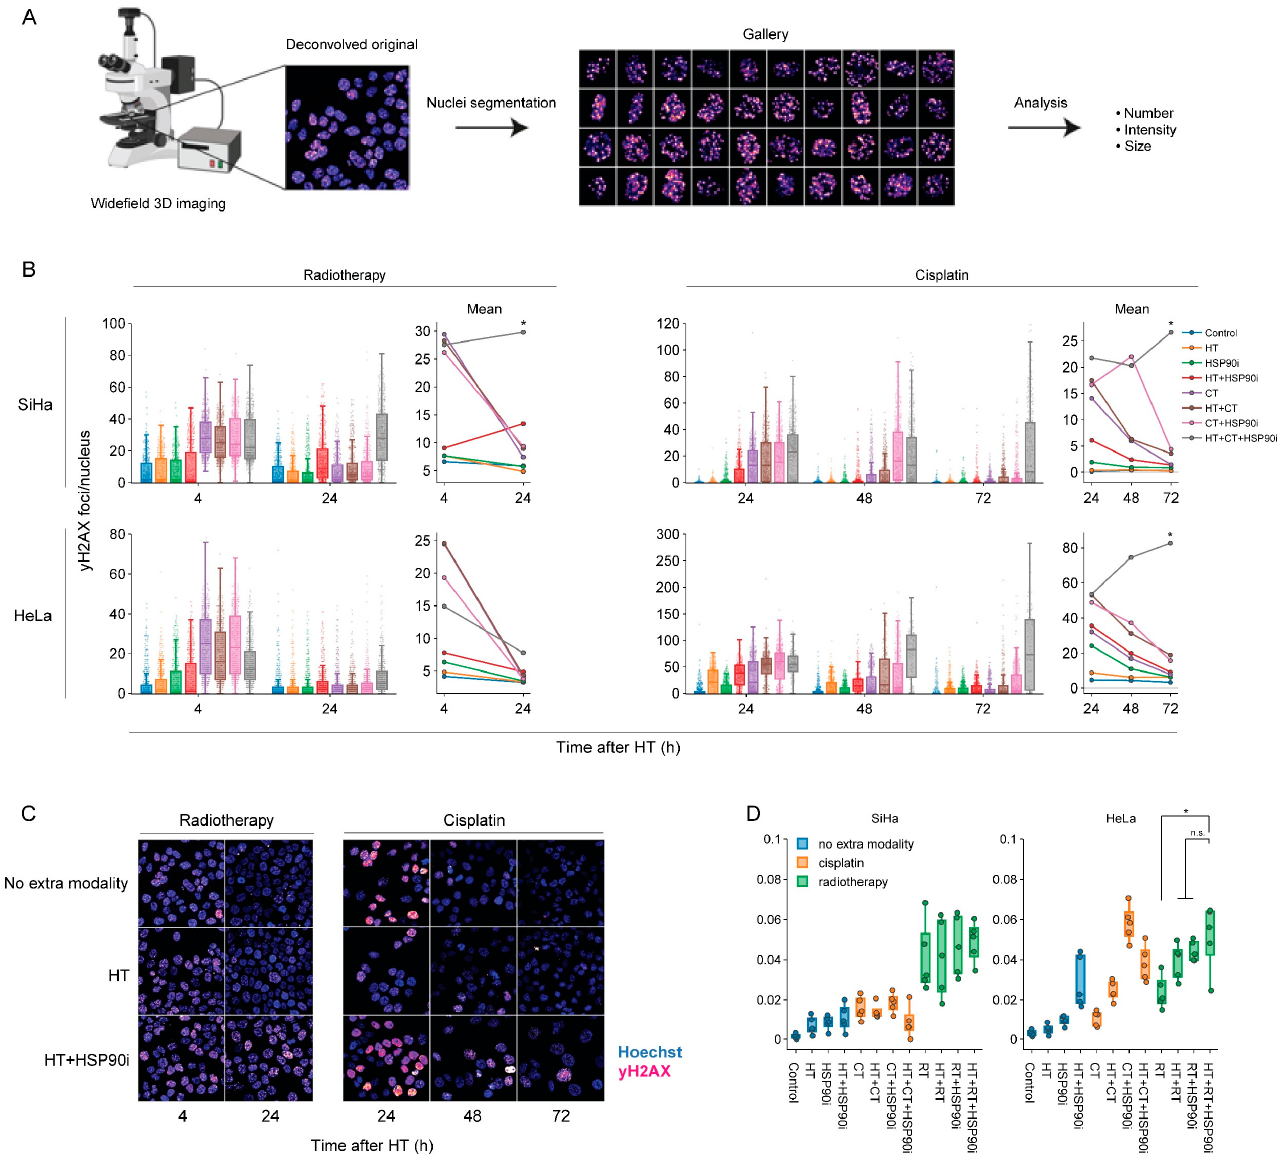
Figure 5. Ganetespib hampers DNA double-strand break repair after radio- and chemo-thermotherapy. ( A ) Image processing pipeline. Cells were imaged in 3D mode and images were deconvolved. Maximum intensity projections were then generated and used as input for the segmentation of cell nuclei, micronuclei and yH2AX foci. ( B ) Boxplots showing the number of yH2AX foci per cell, and line plots displaying the mean number of yH2AX foci after combinations of 2 Gy of radiotherapy (RT), 3.3 µ M of cisplatin (CT), and hyperthermia (HT) in the presence or absence of 30 nM of ganetespib (HSP90i). Noteworthy significant differences are marked with an asterisk. Not significant: “n.s.”. ( C ) Representative images used for quantification. Scale bar: 30 µ M. ( D ) Percentage of cells harboring at least one micronucleus 48 h after HT.